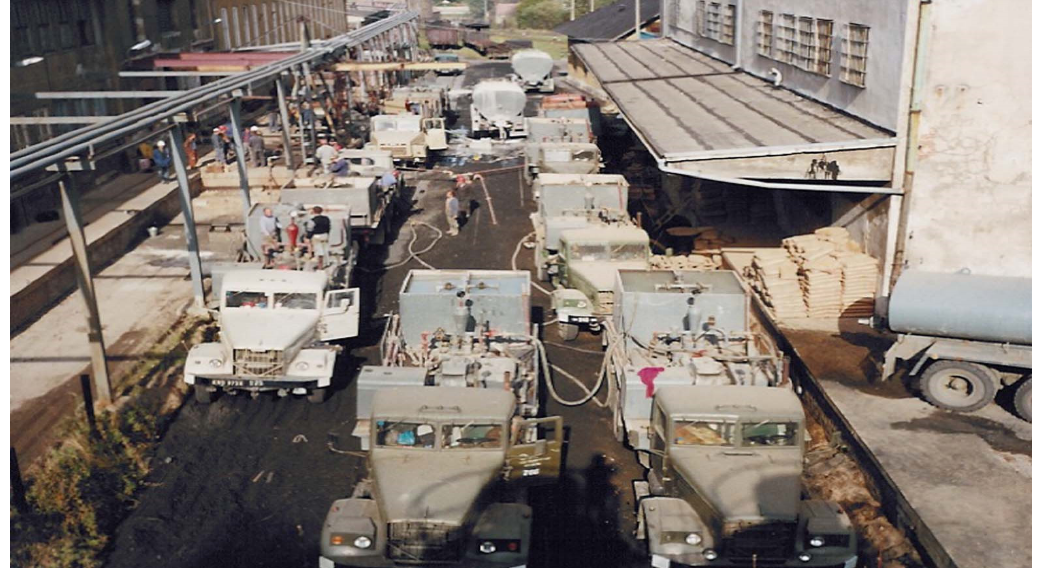
Figure 5. Preparation and injection of the slurry to the Poniatowski transverse [21].